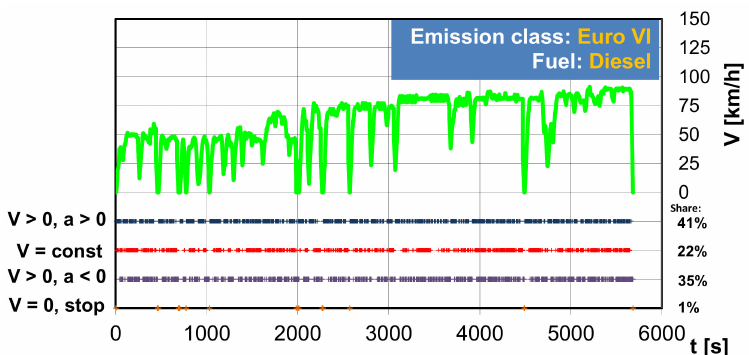
Figure 16. Distribution of speed over time for N3 category